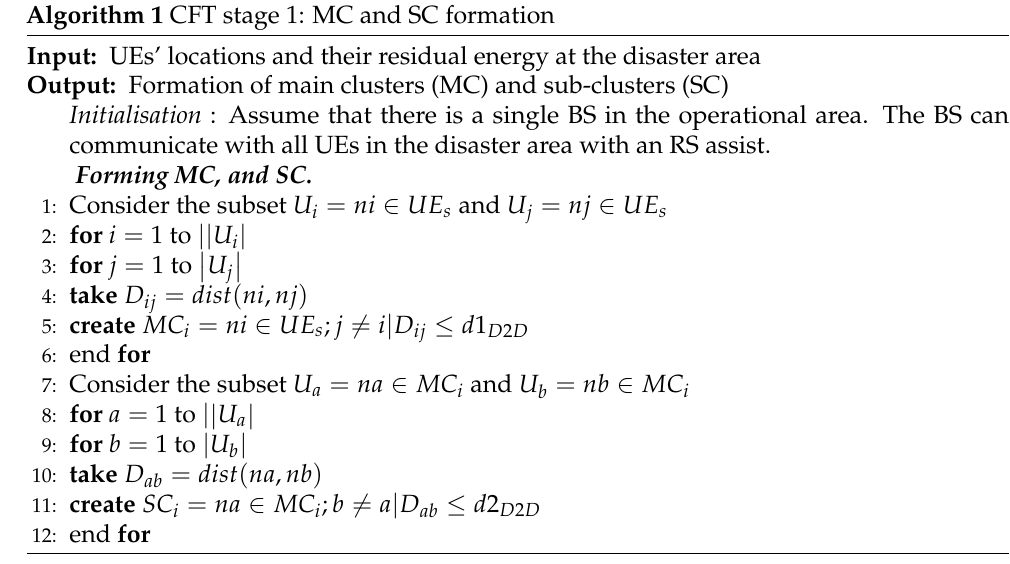
Algorithm 1 CFT stage 1: MC and SC formation